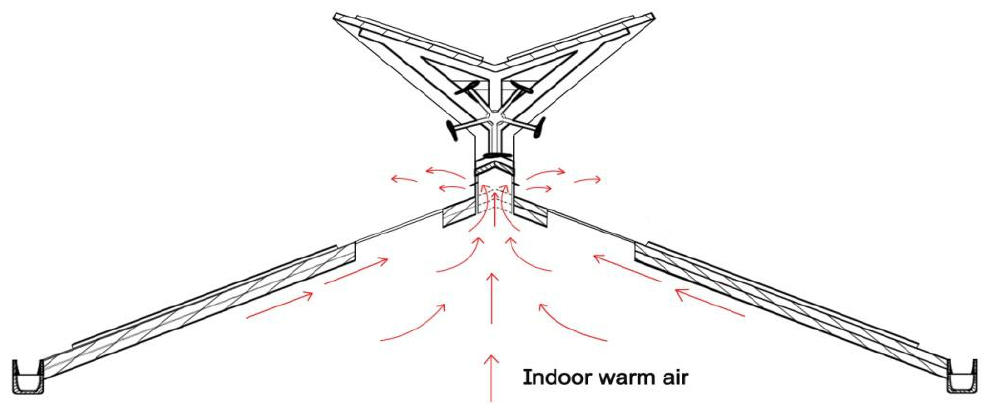
Figure 7. Air ventilation schematic diagram.